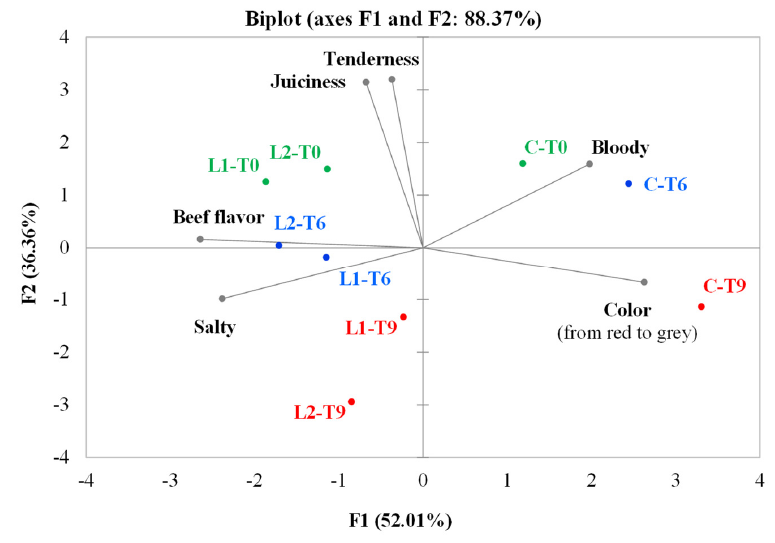
Figure 3. Representation of the cases and variables obtained from PCA related to the results of the QDA ® of the three samples under examination (C, control (minced beef meat + maltodextrine + starter cultures); L1, minced beef meat + starter cultures + 87.5 mg phenols/kg of meat; L2, minced beef meat + starter cultures + 175 phenols/kg of meat) evaluated at all the storage times (T0, T6, and T9).